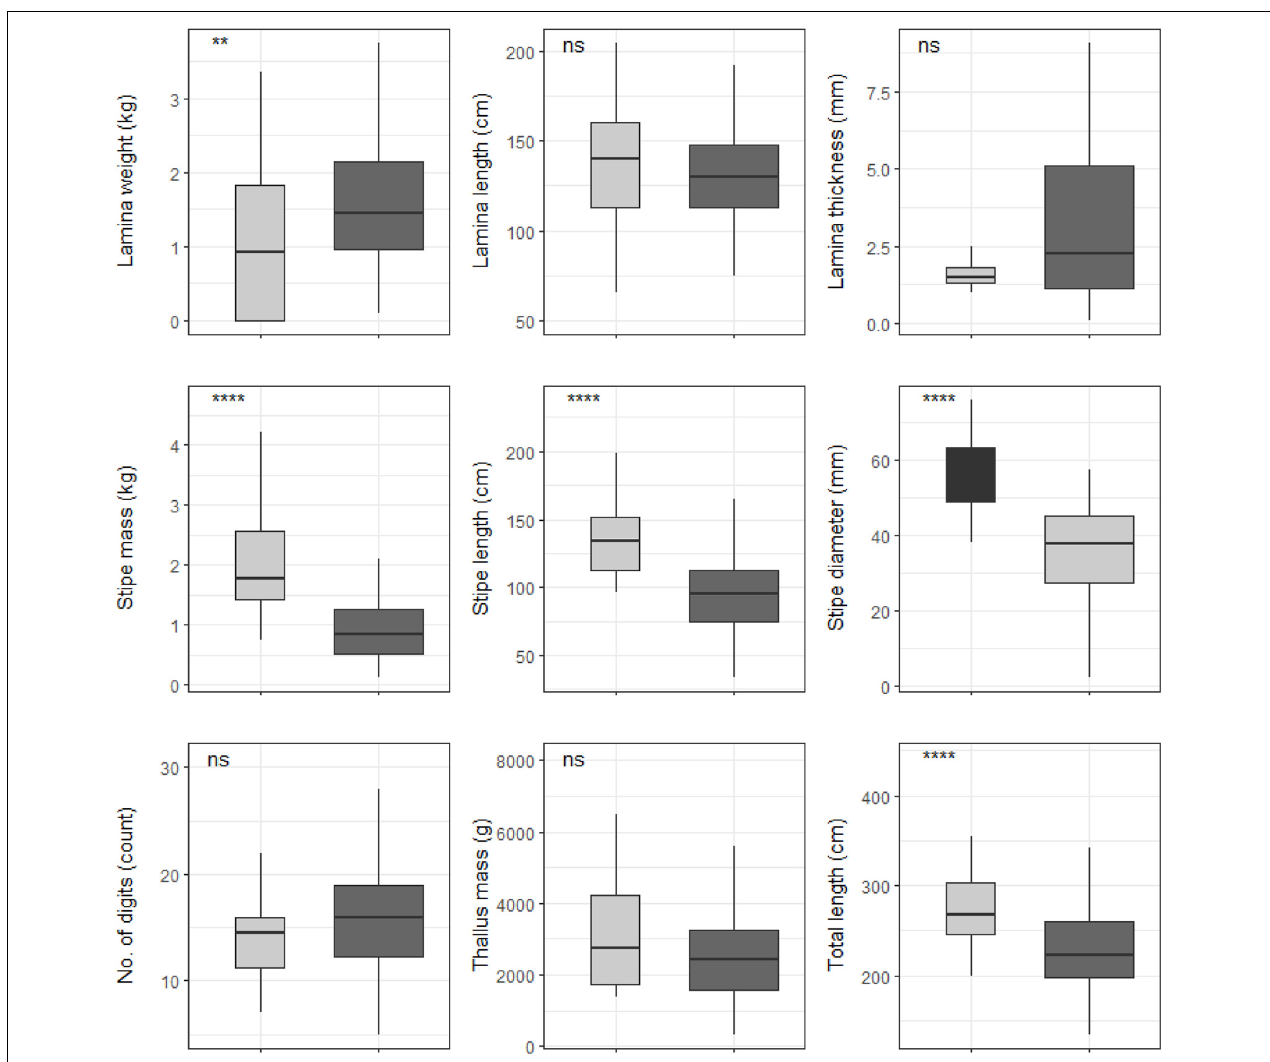
FIGURE 6 | Boxplots representing L. pallida morphological characteristics grouped by temperature regime measured around the Western Cape coastline, with the y -axis depicting the specific morphology measured, with units provided. The lower and upper “hinges” correspond to the first and third quartiles. The whiskers represent the range, solid black lines represent the median and black dots are outliers. Light gray boxes represent cool-temperate and dark gray warm-temperate. Significance levels are as follows: * represents ≤ 0.05, ** represents ≤ 0.01, *** represents ≤ 0.001, **** represents ≤